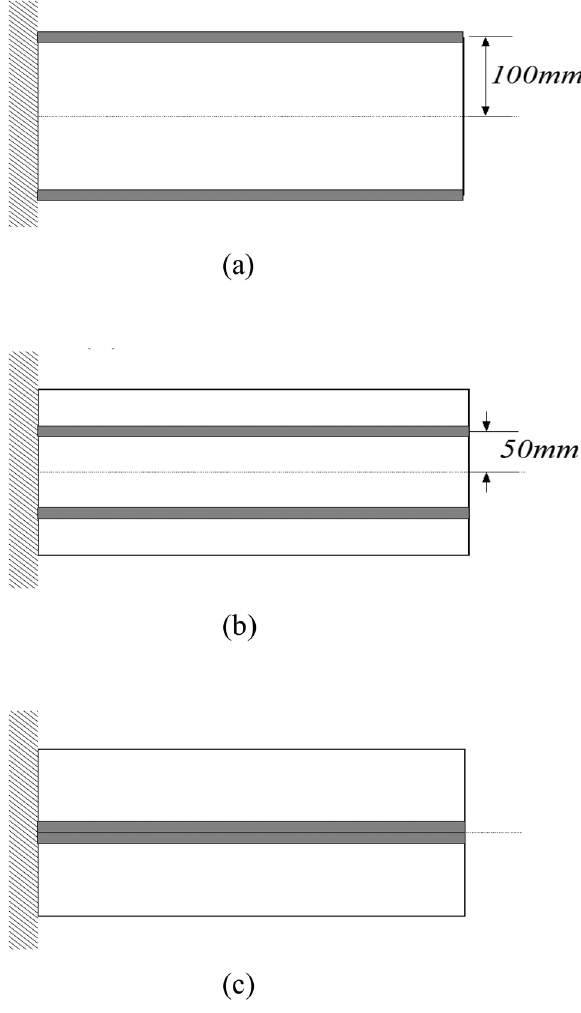
Figure 6: Three cases of shear - web location: ( a ) case 1, ( b ) case 2 and ( c ) case 3.